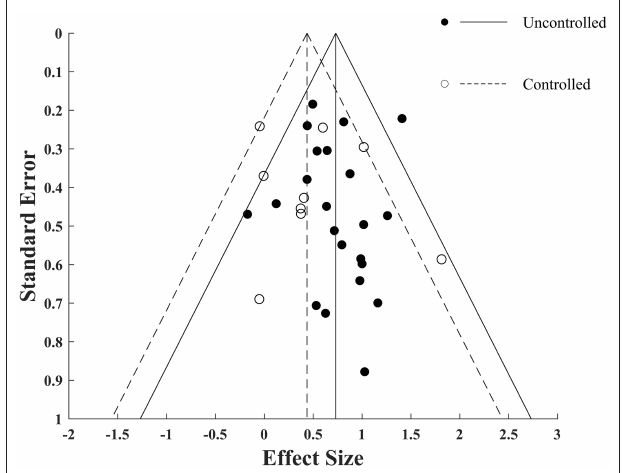
FIGURE 6 | Funnel plot for VR training effectiveness of both uncontrolled and controlled trials with pseudo 95% confidence interval. Filled and empty circles represent Hedges g value of uncontrolled and controlled trials respectively. Solid lines represent g with 95% confidence interval of uncontrolled trials and dashed lines represent g with 95% confidence interval of controlled